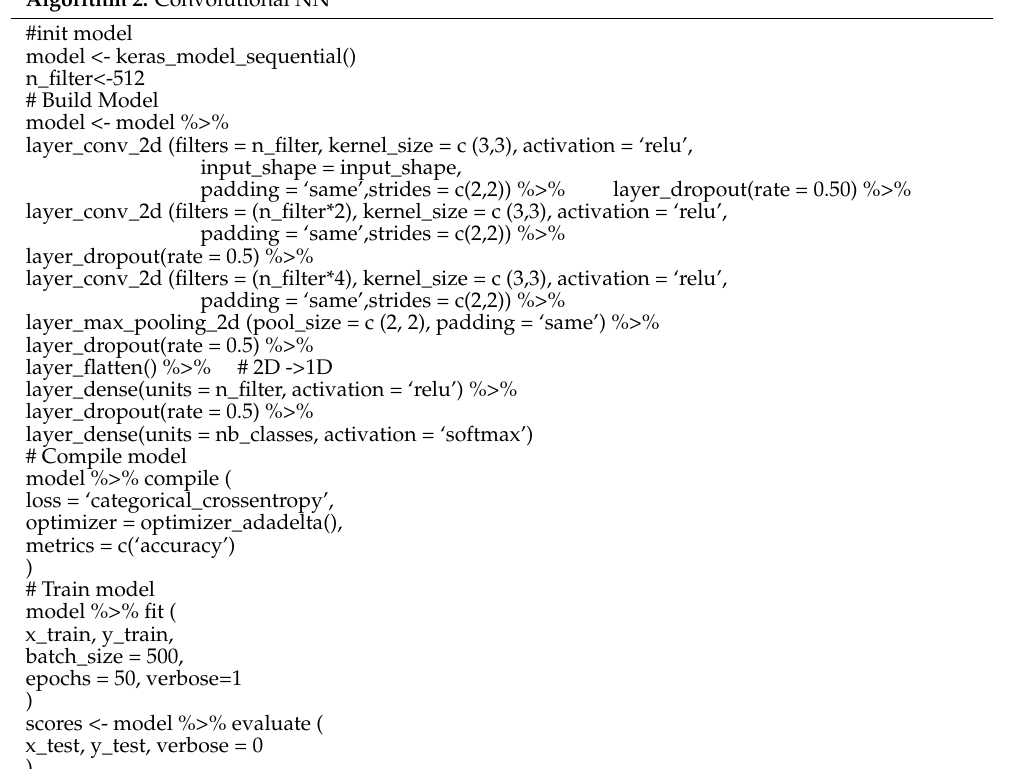
Algorithm 2. Convolutional NN